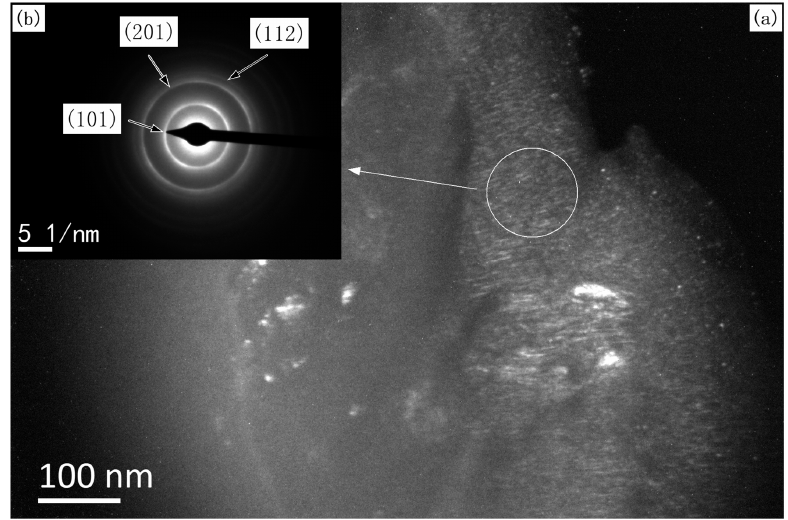
Figure 5. TEM images of the synthesized TiB 2 film formed by CVD with a TiCl 4 /BCl 3 gas flow ratio of 0.5: ( a ) dark field image, ( b ) corresponding selected-area electron diffraction pattern.